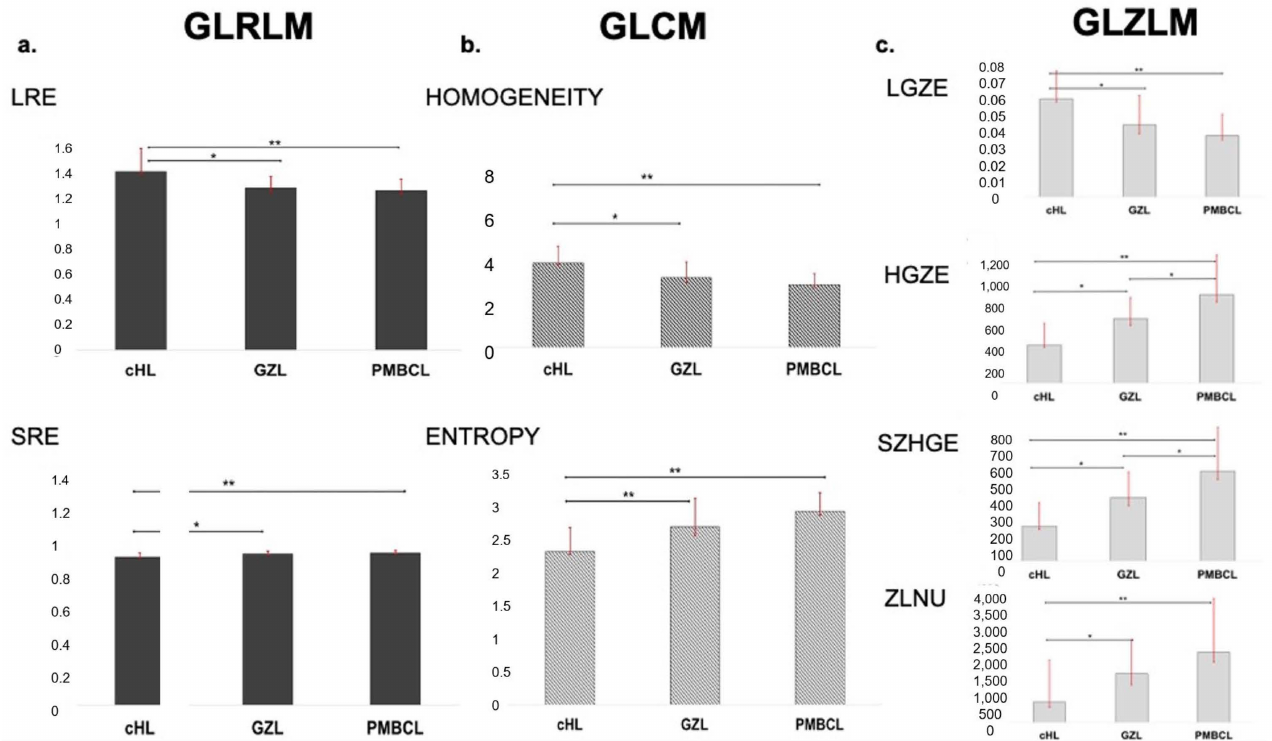
Figure 4. Histograms representing mean LRE and SRE derived from GLRLM ( a ), homogeneity and entropy derived from GLCM ( b ) and LGZE, HGZE, SZHGE and ZLNU derived from GLZLM ( c ) in the subsets of cHL, GZL and PMBCL. * p < 0.05, ** p <